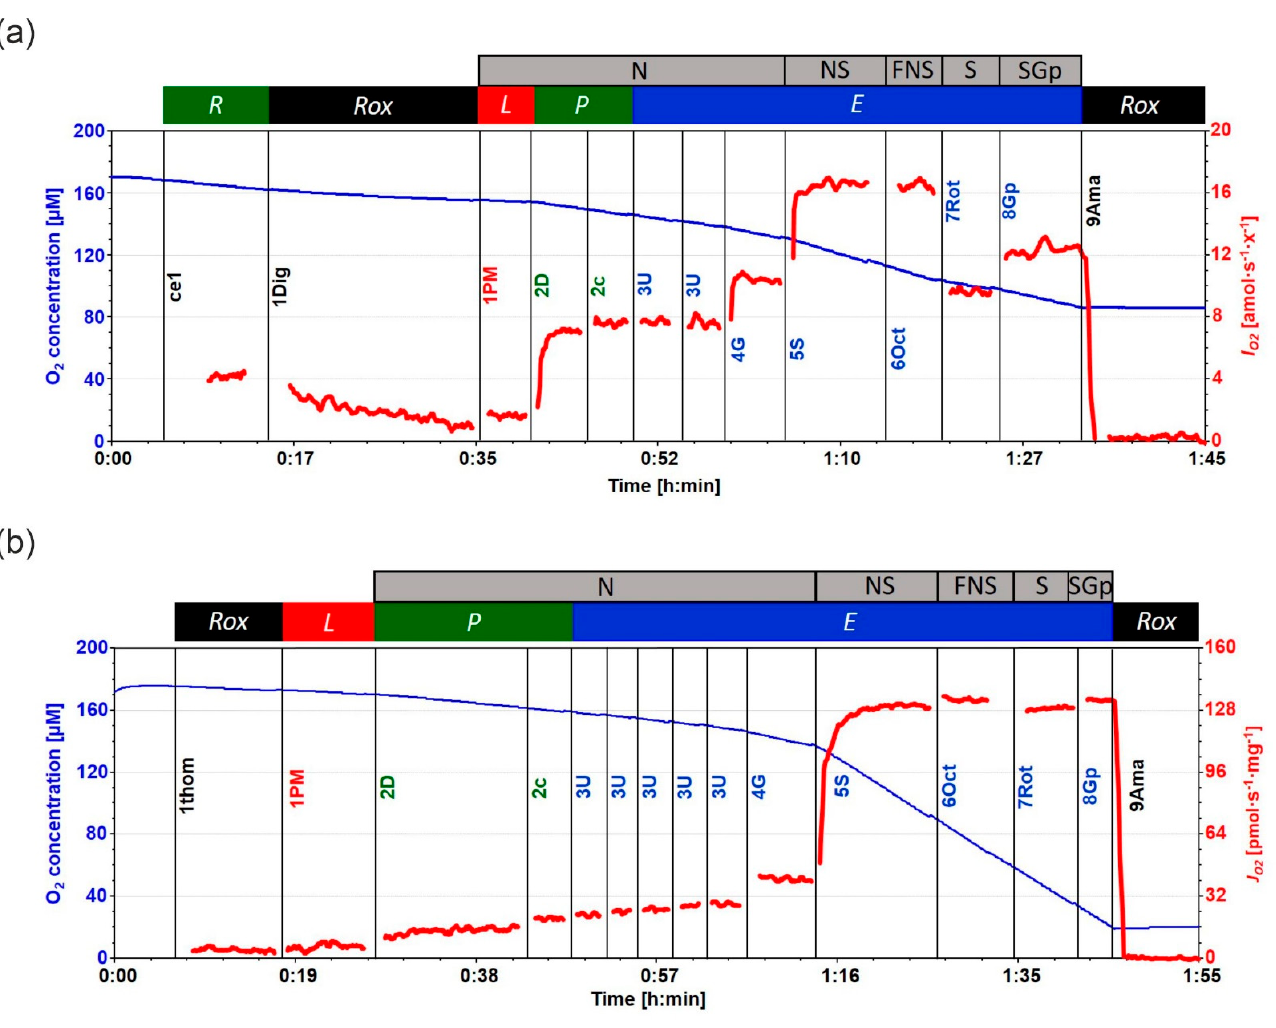
Figure 6. Representative traces of substrate-uncoupler-inhibitor titration (SUIT, SUIT-001 O2 ce-pce D003, and SUIT-001 O2 mt D001) protocol for measurement of ( a ) PBMC and ( b ) liver mitochondrial respiration using high-resolution respirometry. ( a ) ce1 : ROUTINE respiration ( R ) was measured in